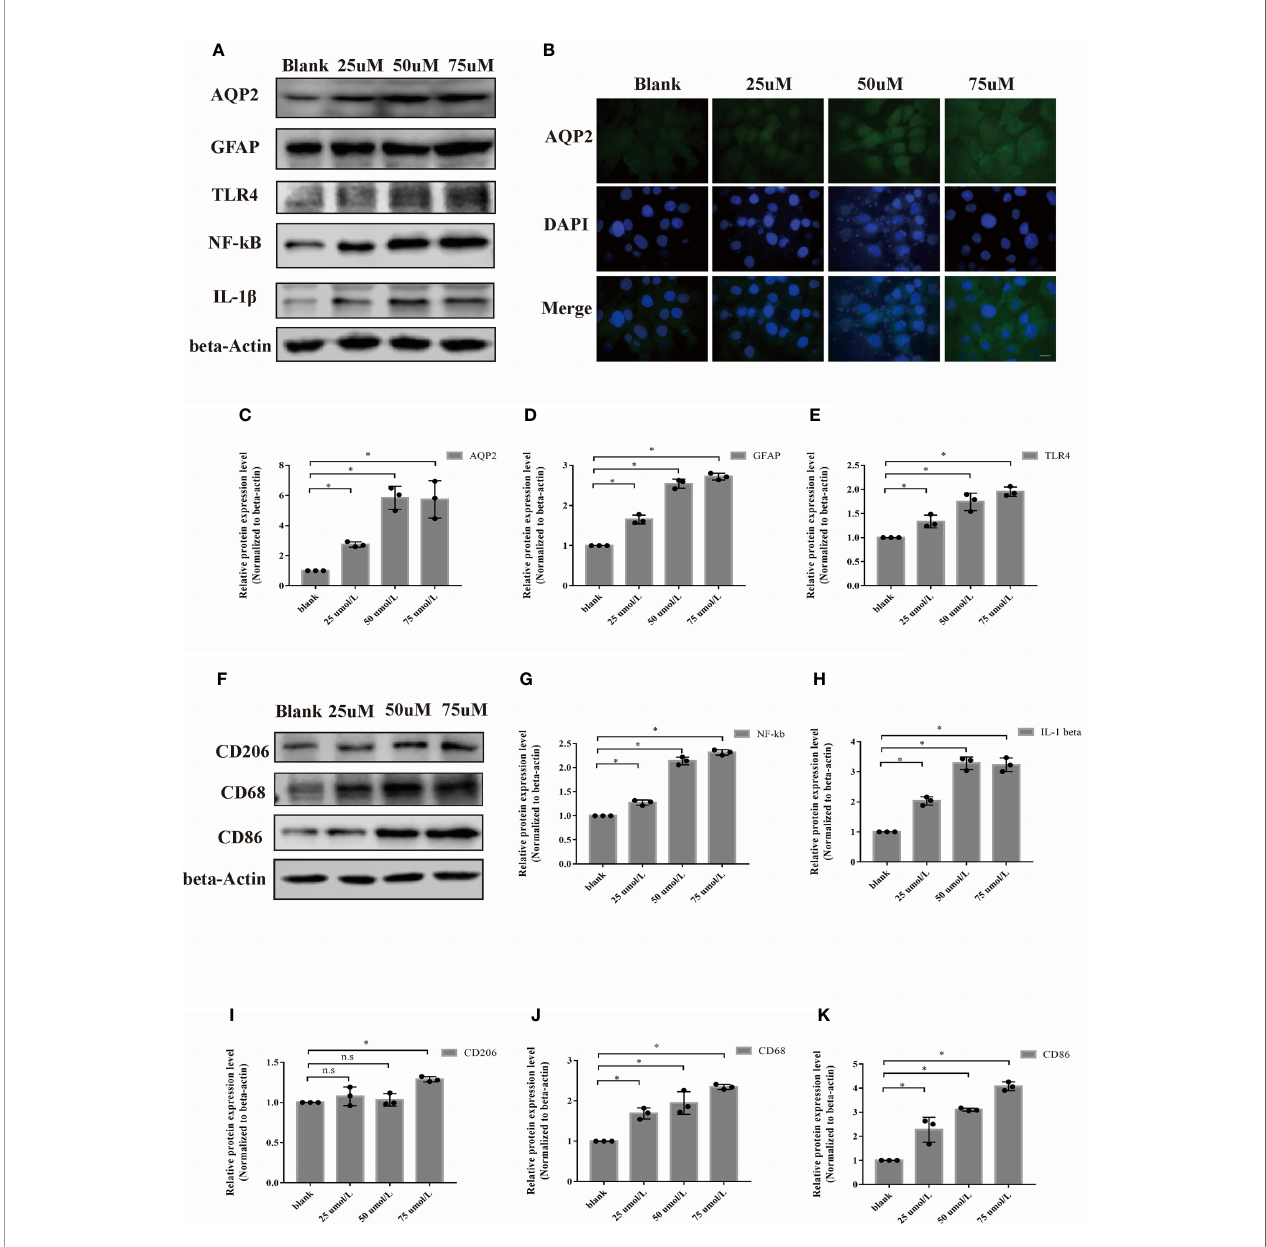
FIGURE 3 | Hemin induced astrocyte activation and microglia polarization. Astrocyte was exposed to hemin for 24 h. (A) AQP2, GFAP, TLR4, NF-kB and IL-1 b protein levels in rat astrocyte cell line CTX-TNA2 were assessed by western blotting in the blank control group, and different groups were treated with several concentrations of hemin (n = 3/group). (B) Astrocyte exposed to hemin for 24 h were stained with antibodies to AQP2 (green signal) and visualized by immuno fl uorescence microscopy. Astrocyte were immunostained for nuclei (blue, DAPI). Representative images are shown. Scale bar: 10 m m. Quanti fi cation of the relative protein expression level of AQP2(C), GFAP (D) , TLR4 (E) , NF-kB (G) and IL- b (H) after 24 h hemin treatment. *p < 0.05 vs. the blank group without hemin. (F) CD206, CD68 and CD86 protein levels in microglia in the blank control group were assessed by western blotting, and different groups were treated with several concentrations of hemin (n = 3/group). Quanti fi cation of the relative protein expression level of CD206 (I) , CD68 (J) and CD86 (K) are shown. *p < 0.05 vs. the blank group without hemin. The data are presented as the mean ± s.d. of three independent